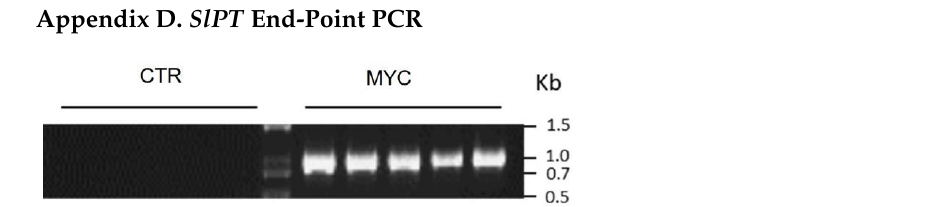
Figure A1. End-point PCR of cDNA obtained from mycorrhiza-colonized (MYC) and non-colonized